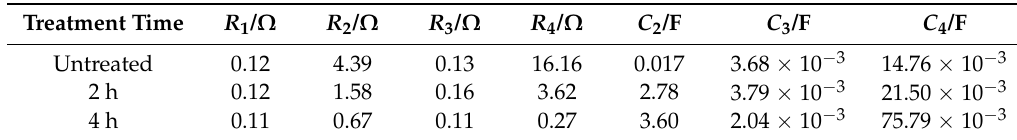
Table 1. Resistances ( R 1 – R 4 ) and capacitances ( C 2 – C 4 ) for the ZrNi negative electrode with and without the alkaline treatment for 2 h and 4 h.